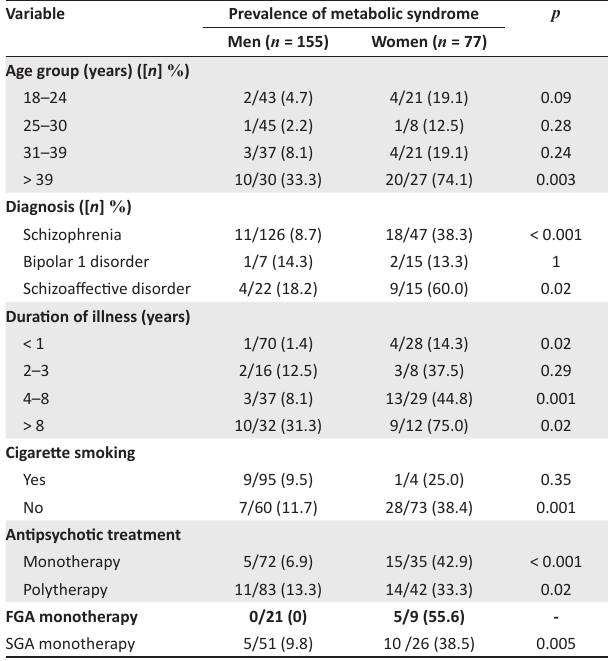
TABLE 3: Stratified analysis of the factors associated with the prevalence of metabolic syndrome in men ( n = 155) and women ( n = 77) with severe mental